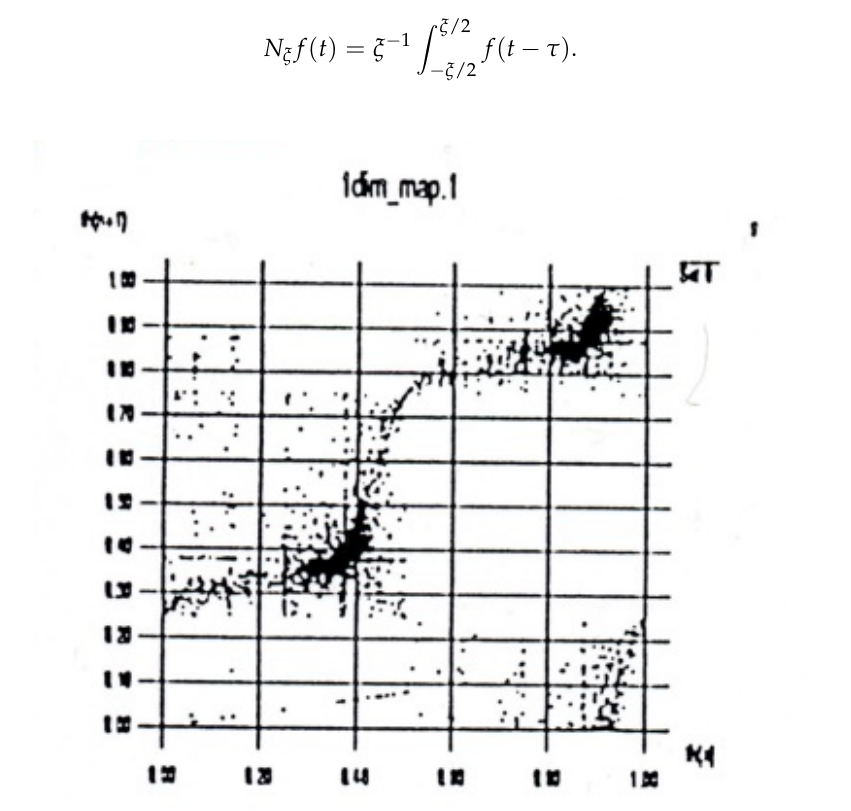
Figure 1. Data plot suggesting the model we studied ([21]).